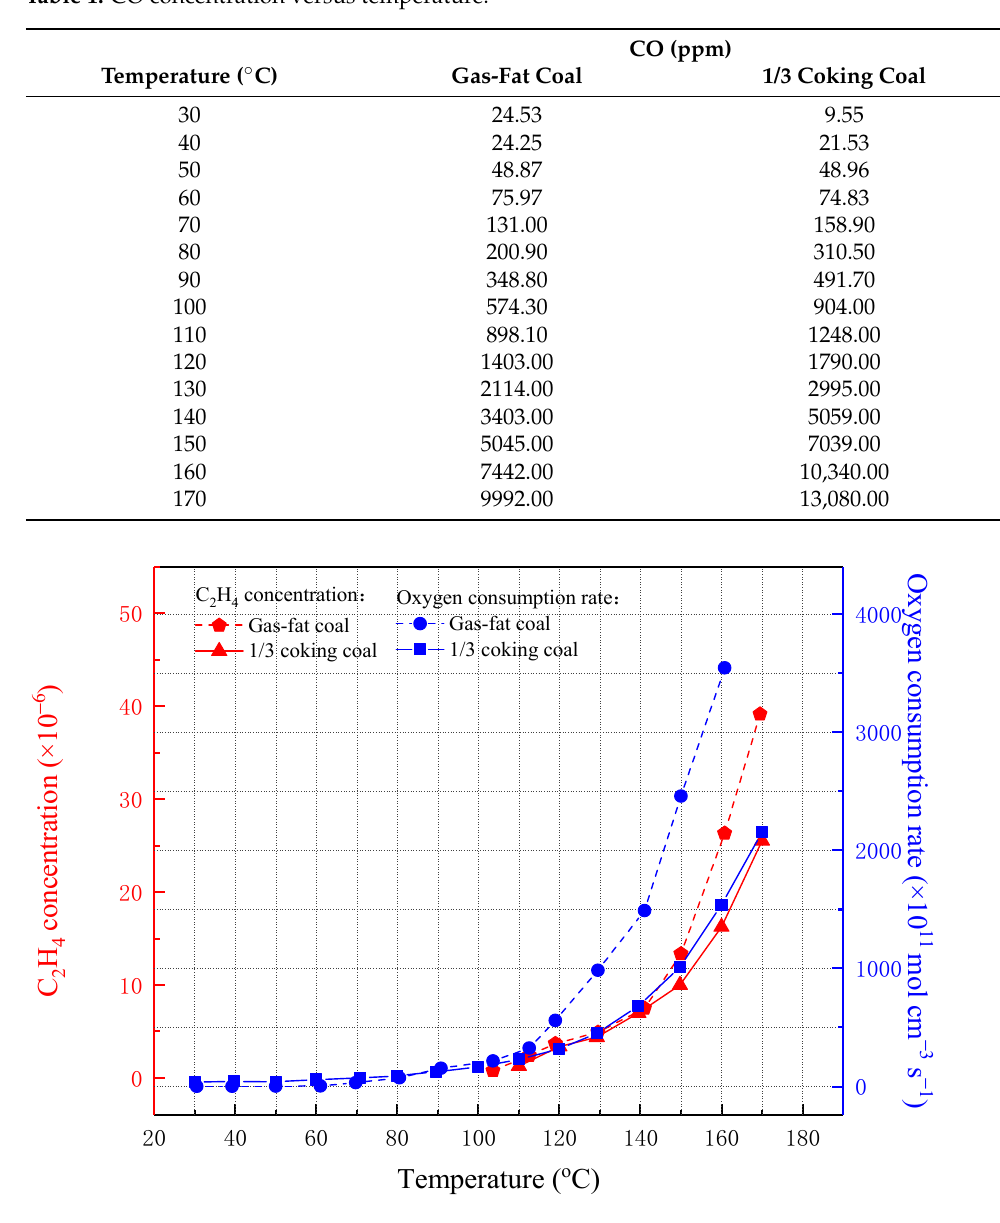
Figure 2. The curve of C 2 H 4 concentration and oxygen consumption rate versus temperature. CO concentration increased as the temperature rose. As to gas-fat coal, CO concen- tration was amplified very tardily and lower than 1000 ppm at an early oxidation stage (under 70 ◦ C). However, when the heating temperature increased from 70 to 100 ◦ C,